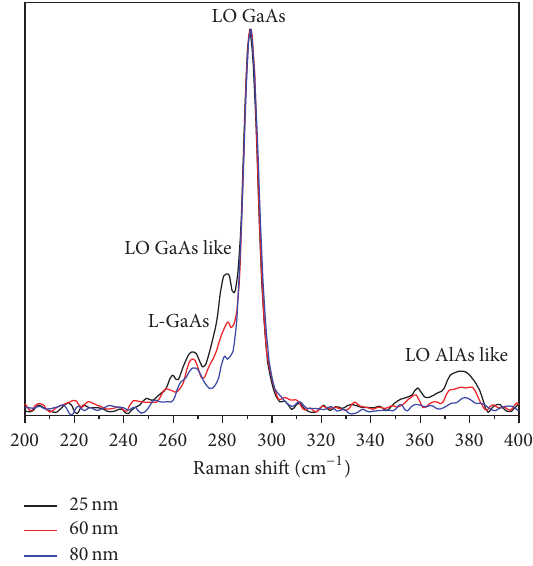
Figure 5: Raman scattering of M1, M2, and M3 heterostructures, capped with GaAs layer of 25, 60, and 80 nm, respectively.